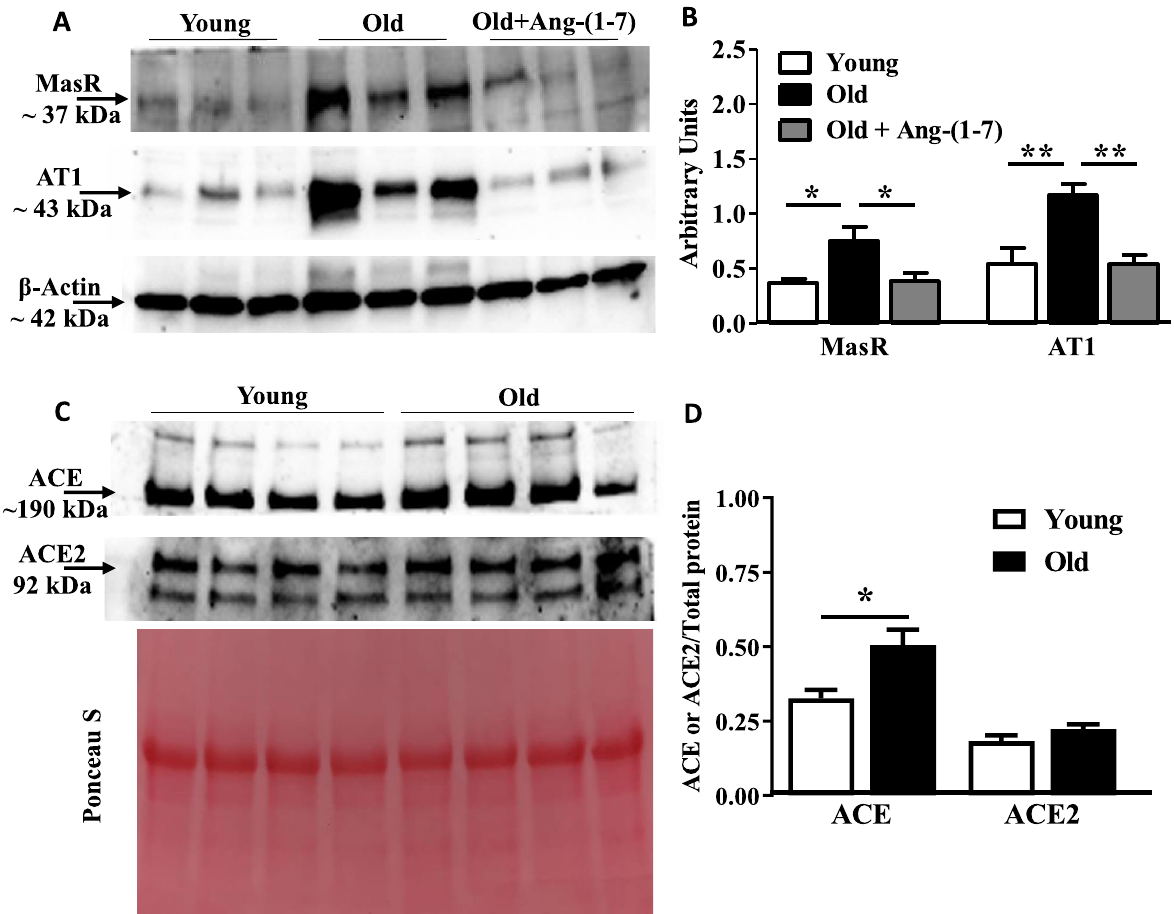
Figure 1. Aging alters expression of angiotensin receptors and ACEs in bone marrow cells: ( A ) Representative western blots for MasR and AT1R protein expressions in the bone marrow Lineage-depleted cells ( A ) and ACE and ACE2 ( C ) protein levels in the bone marrow supernatants derived from Young and Old mice. ( B ) Protein expression of both MasR and AT1R was higher in the Old cells compared to the Young, was decreased to levels similar to that observed in Young by Ang-(1–7) treatment (P < 0.05 and P < 0.01 for MasR and AT1R, respectively, n = 6). Groups were compared by One-way ANOVA followed by Tukey’s post-test. ( D ) ACE protein levels in the bone marrow supernatant were higher in the Old compared to the Young (P < 0.05, n = 8) while ACE2 levels were unchanged. Statistical differences were tested by using unpaired Students’ number of monocytes (P < 0.001, n = 6), and M1 macrophages (P < 0.001, n = 6) compared to the Young with similar number of M2 macrophages (Fig. 2E,F). M1/M2 (P < 0.001, n = 6) ratio was higher in the cells derived from Old BM compared to the Young (Fig. 2G). BM-cells derived from Ang-(1–7)-treated mice showed decreased myelopoiesis in BM-cells from Old mice as evident from the decreased number of monocytes compared to the